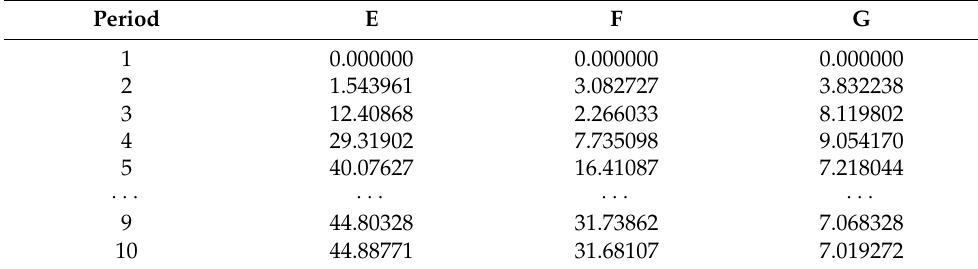
Table 8. The results of variance decomposition of carbon emission